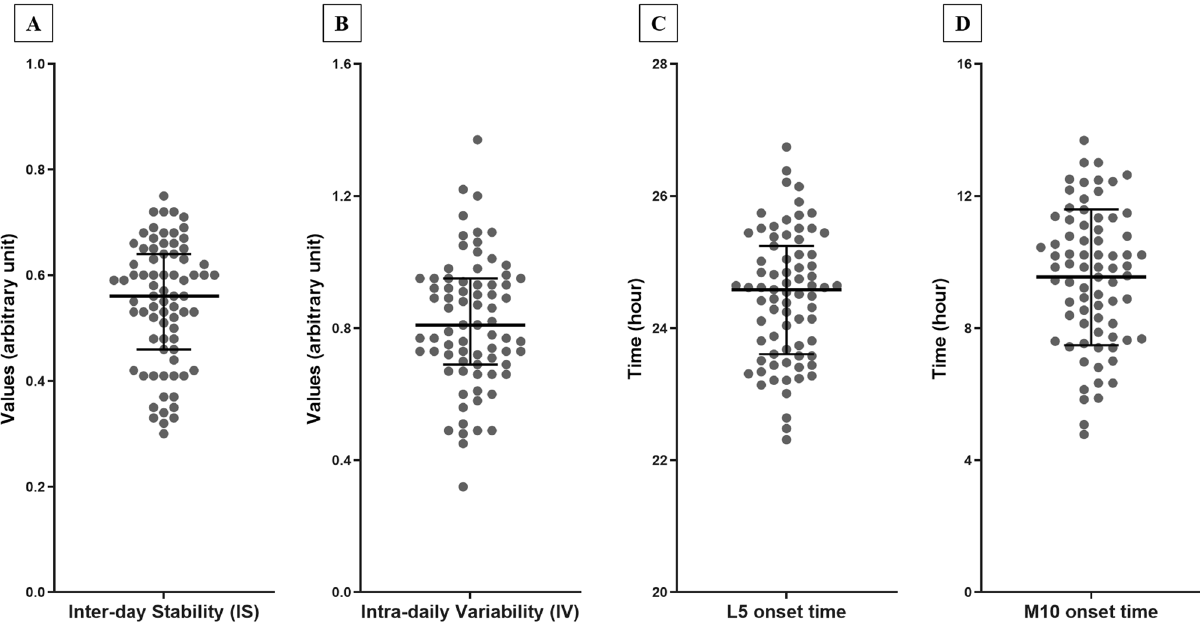
Figure 3. Distributions of rest-activity patterns and circadian phase variables. Rest-activity pattern variables are expressed as arbitrary units. Circadian phase variables are expressed as time units. Circles indicate patients. Bars in the middle indicate medians, while error bars indicate interquartile range. IS inter-daily stability, IV intra- daily variability, L5 onset time least active 5-h onset time, M10 onset time most active 10-h onset